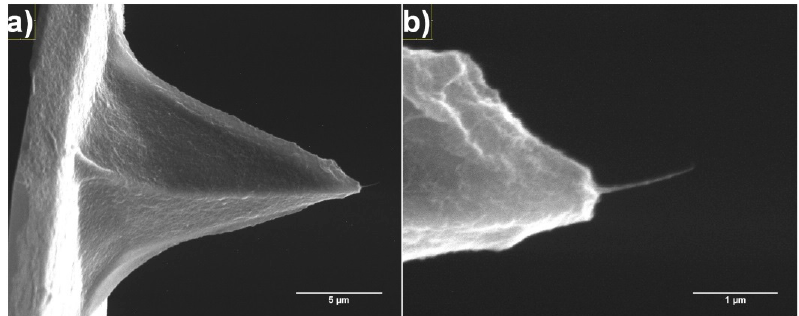
Figure 6. SEM images of a CNT fibre attached to the apex of an AFM probe from the solvent evaporation method showing ( a ) low and ( b ) high magnification of the same tip.